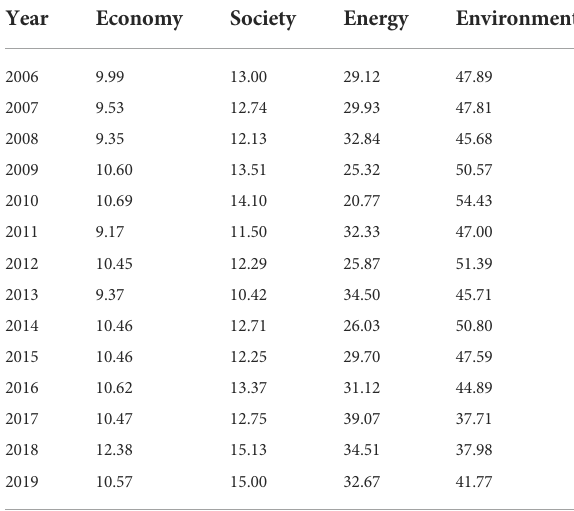
TABLE2Subsystemobstacledegreeoflow-carbondevelopmentlevel index in Fujian province